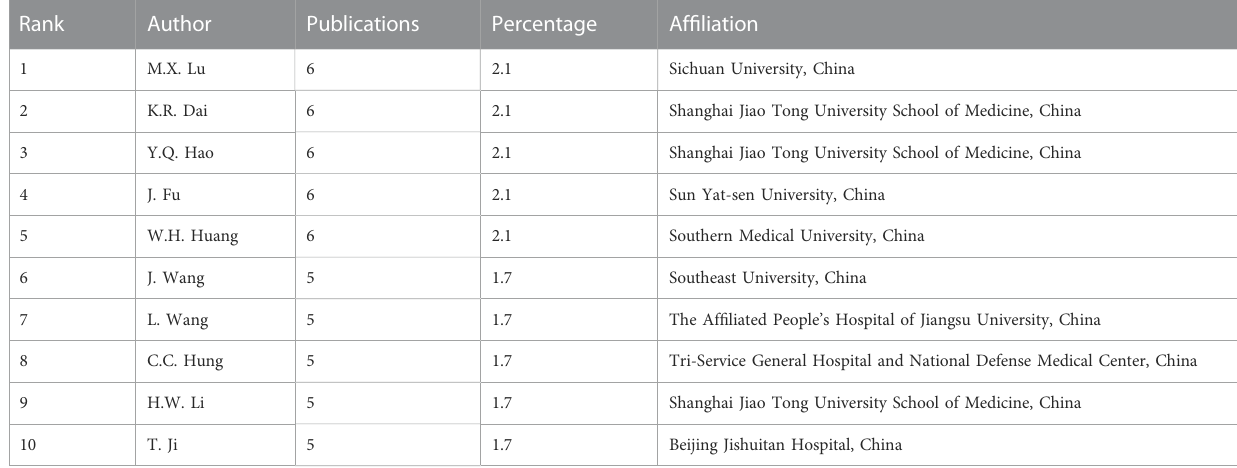
TABLE 5 The 10 high-yield authors in the fi eld of additive manufacturing technology in pelvic surgery.